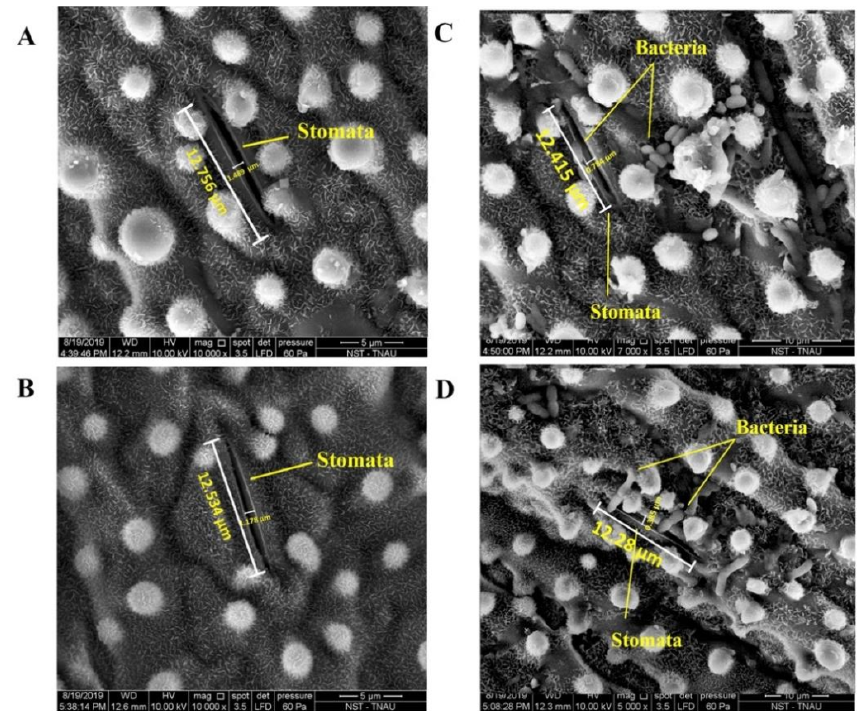
Figure 7. Representative SEM images showing the change in stomatal aperture in control rice plants under normal ( A ) and osmotic stress ( B ) conditions, and B. megaterium PB50 spray inoculated rice plants under normal ( C ) and osmotic stress ( D ) conditions.